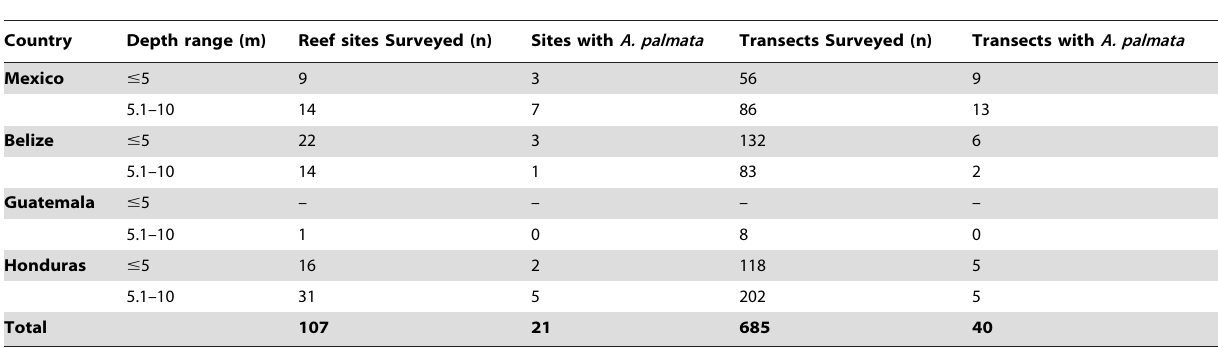
Table 1. Summary of data collected in the Mesoamerican Reef System between 2010 and 2012.